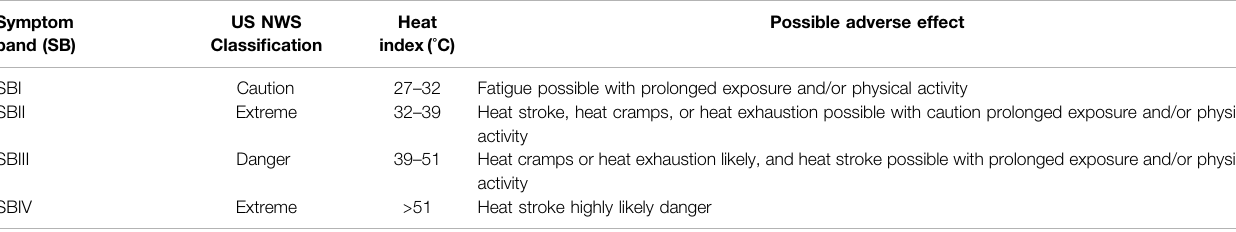
TABLE 2 | Heat index threshold and potential health